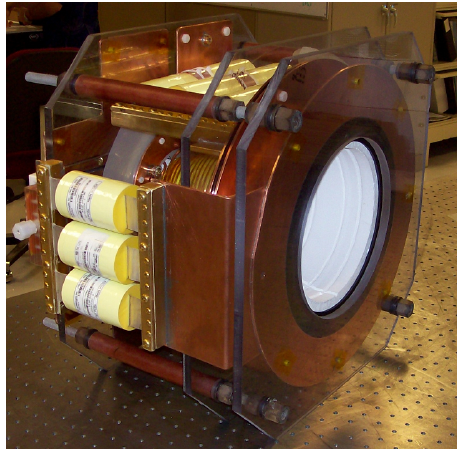
Figure 9. The PT-1 plasmoid thruster test